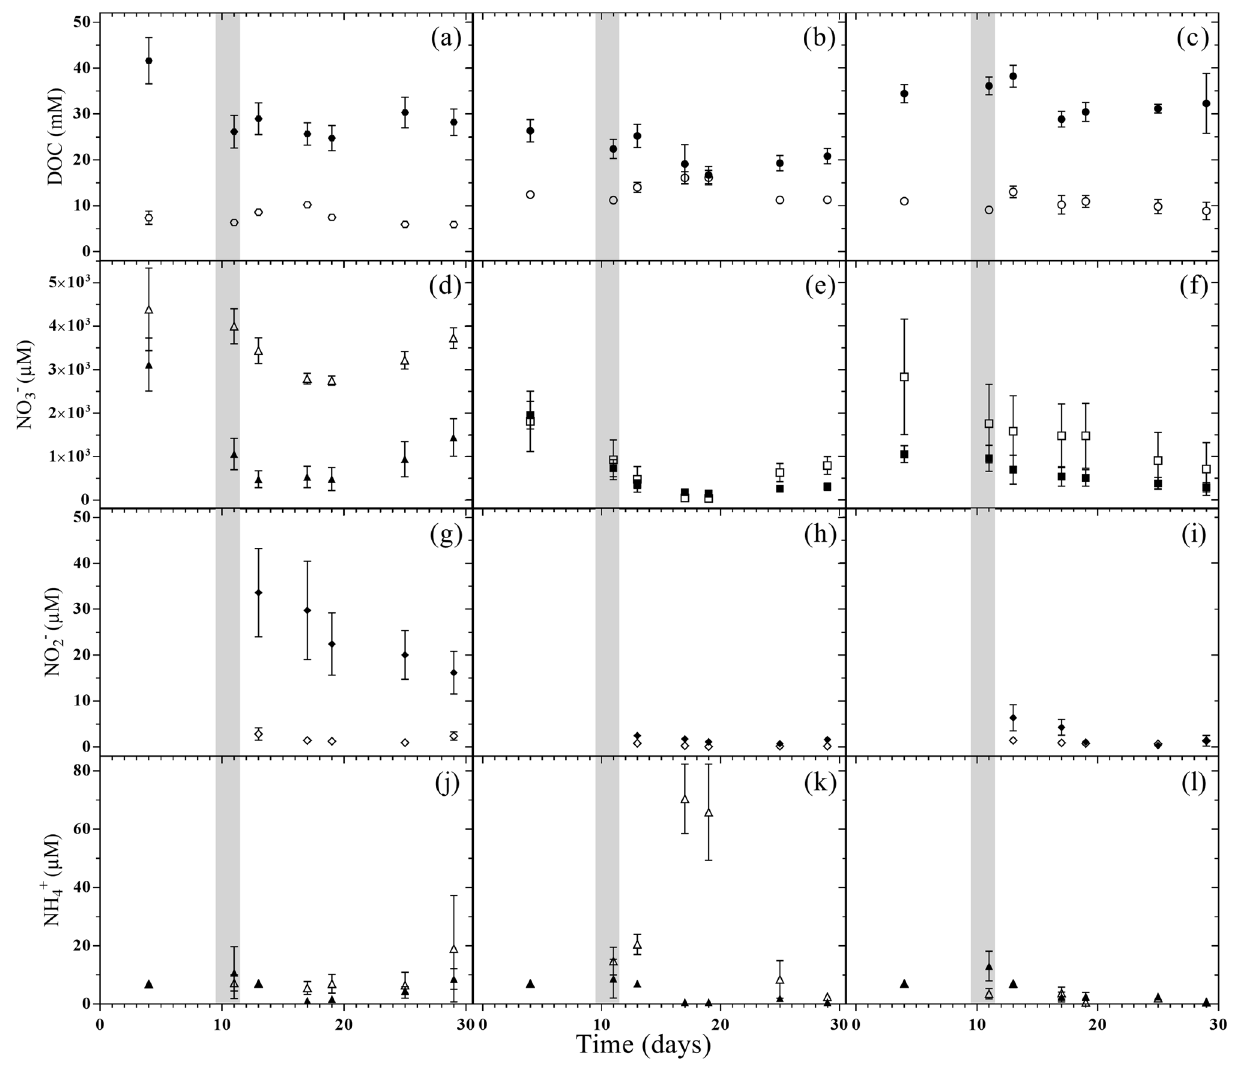
Figure 4. Dissolved organic carbon (DOC, circles), nitrate (squares), nitrite (diamonds) and ammonium (triangles) concentrations in pore water during the flooding–drying experiment. LA (filled symbols) and SA (empty symbols); unamended soils ( a , d , g and j ), litter addition ( b , e , h and k ) and plant treatment ( c , f , i and l ).; (mean ± SE; n =